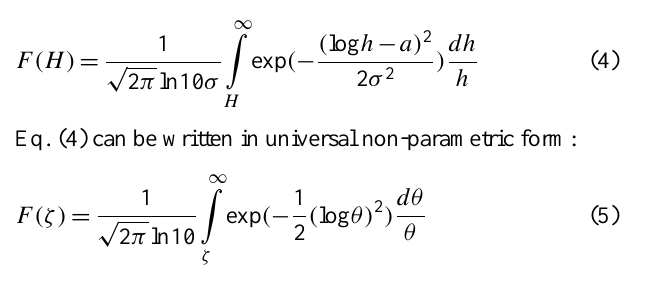
Fig. 2. Histograms of three tsunamis with interval 4m of runup